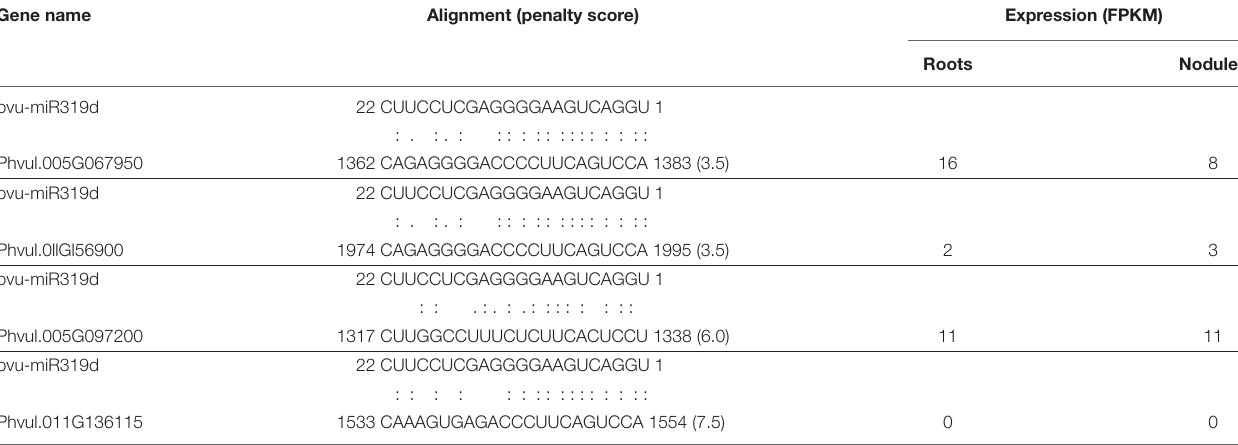
TABLE 1 | Common bean TCP transcripts with miR319 binding